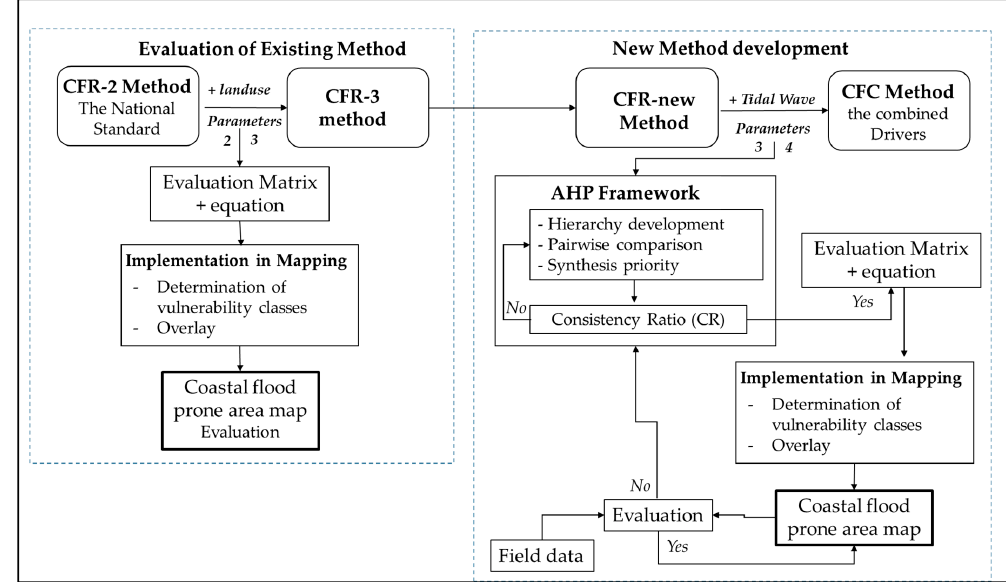
Figure 2. Workflow scheme of the study. CFR: coastal flood-prone areas driven by rainfall.